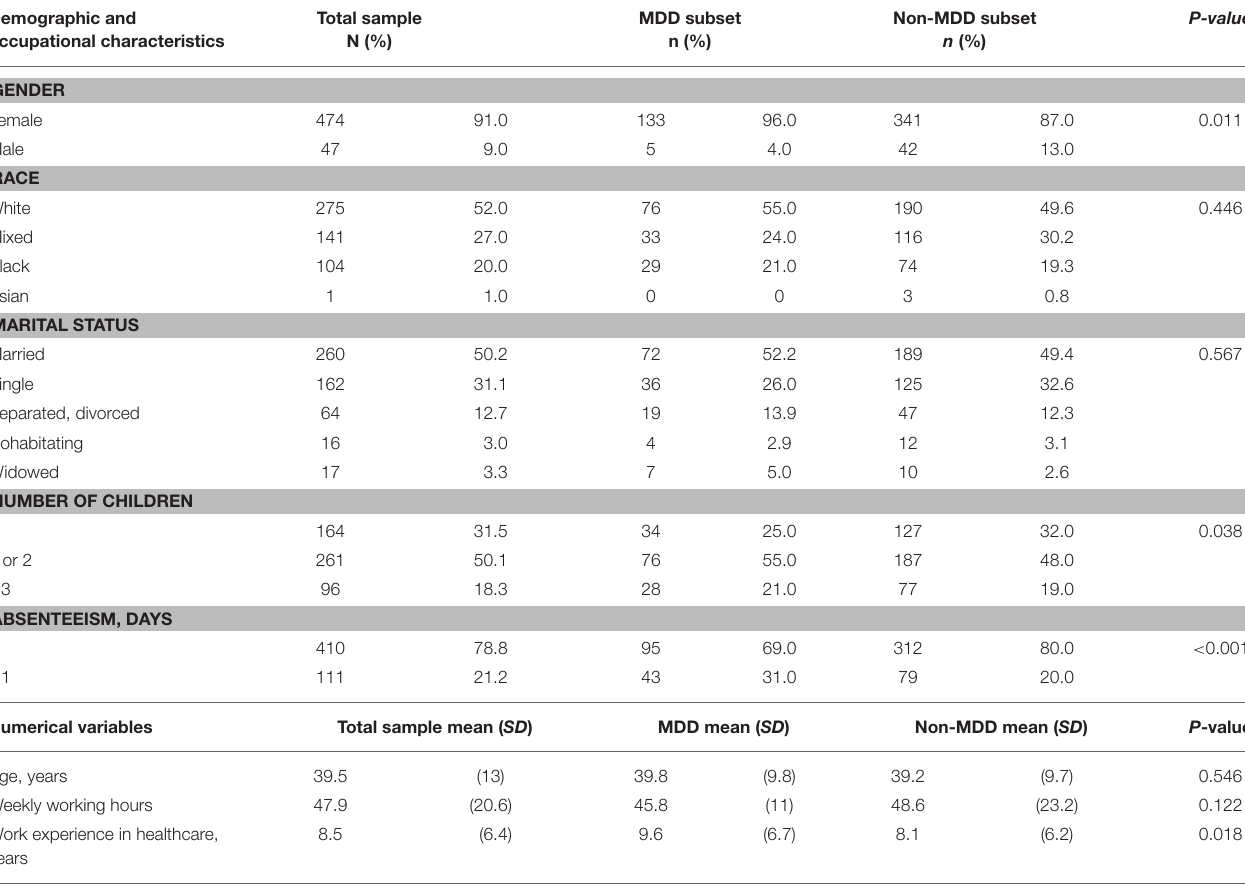
TABLE 1 | Demographic and occupational characteristics of nursing assistants: total sample, MDD and non-MDD subsets. Demographic and occupational characteristics